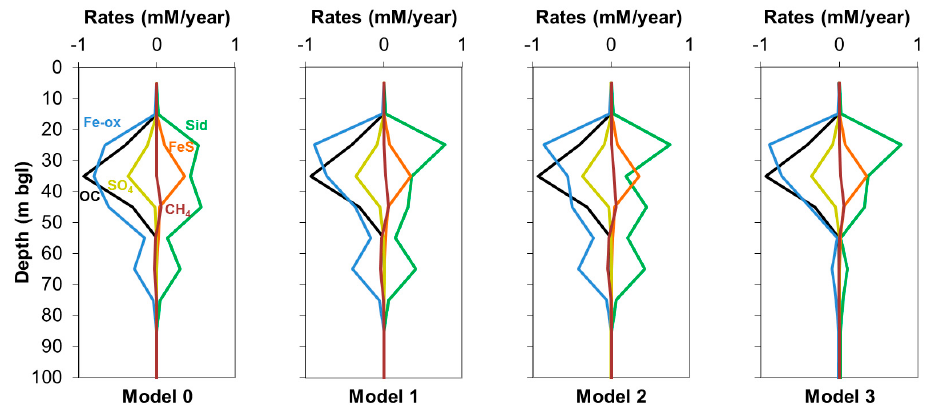
Figure 2. Modeled rates of selected processes over depth; negative rates indicate consumption, positive formation; Fe-ox: Fe-oxide reduction; OC: organic carbon consumption; SO 4 : sulfate reduction; Sid: siderite precipitation; FeS: iron sulfide precipitation; CH 4 : methane formation/oxidation.